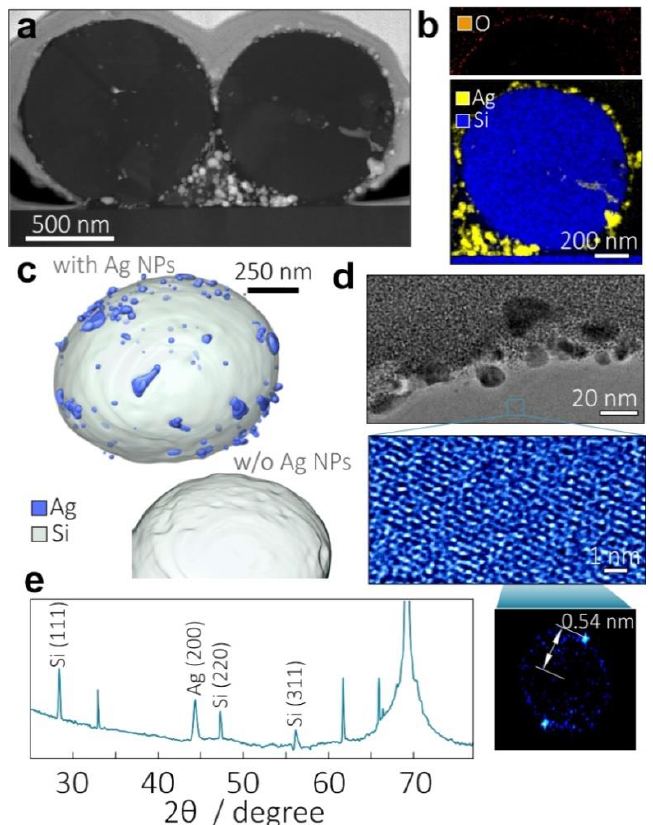
Figure 2. ( a ) STEM image of the cross-sectional central cut made through the 1.1-µm diameter Ag-Si microspheres; ( b ) EDX composition mapping of the right-most Ag-Si microsphere showing distribution of Ag and Si elements as well as an oxide shell (top panel); ( c ) 3D model of the isolated Ag-Si microsphere made through SEM tomographic reconstruction from the series of multiple images of cross-sectional cuts. Bottom panel shows the same model where Ag nanoclusters were removed to illustrate crater-like Si surface morphology; ( d ) TEM image of the Ag-Si microsphere surface (top panel) as well as HR-TEM image and its FFT showing crystalline structure of the Si core (bottom panel); ( e ) XRD pattern of the Ag-Si nanopowder. All unmarked peaks represent contribution from the underlying Si substrate.